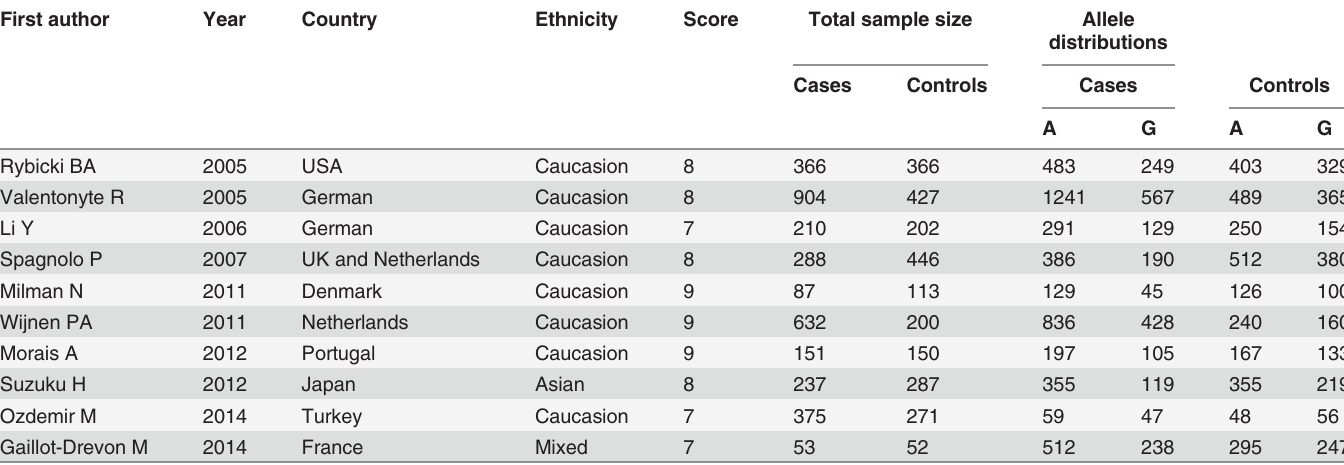
Table 1. The baseline characteristics of all study populations in the